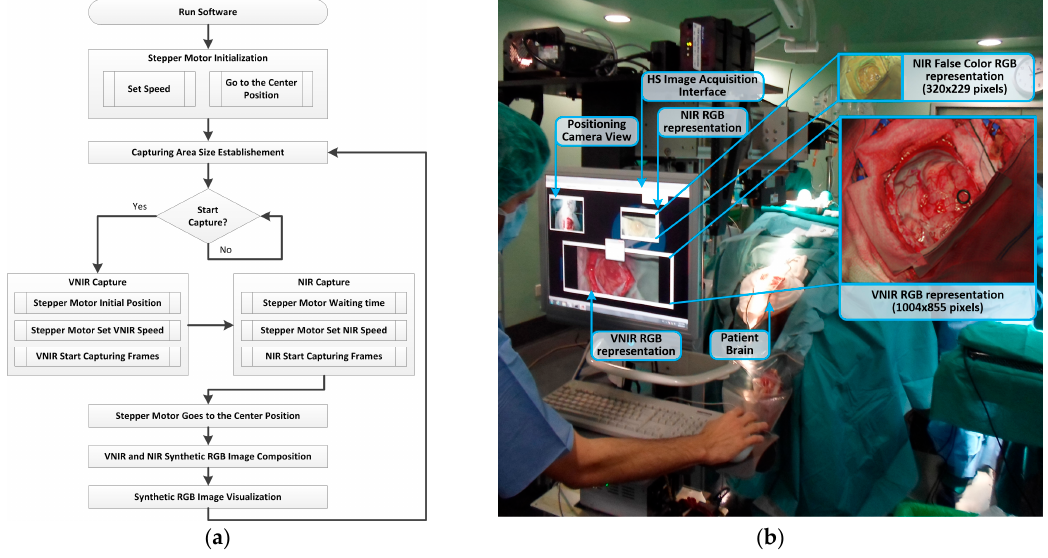
Figure 4. ( a ) HS image acquisition software flow diagram; ( b ) HS image acquisition user interface (and the RGB representations of each HS cube) being used during a neurosurgical intervention at the University Hospital Doctor Negrin of Las Palmas de Gran Canaria (Spain).